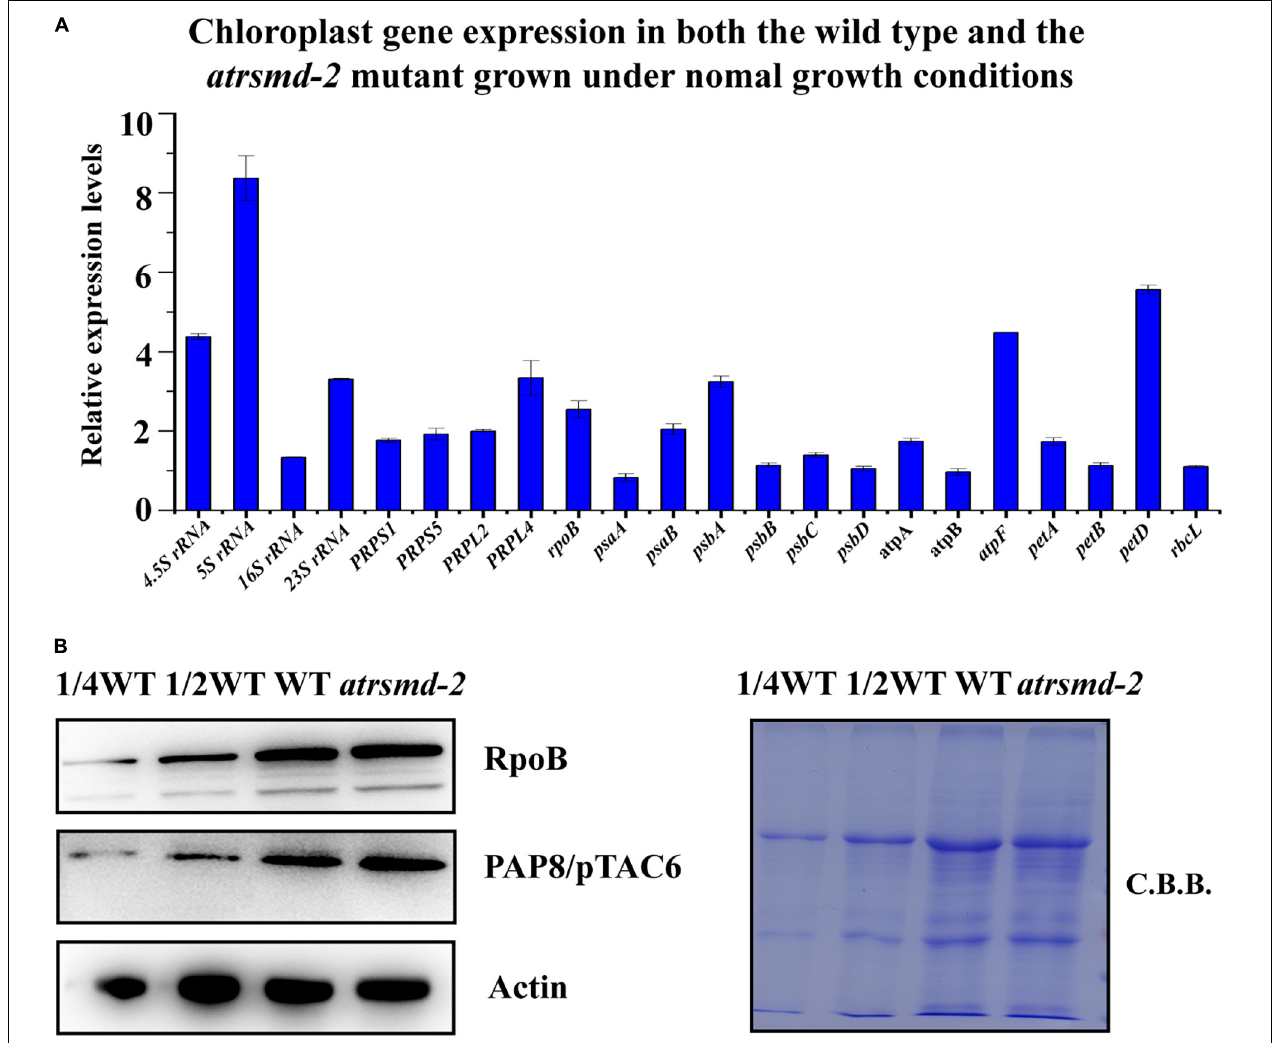
FIGURE 5 | Absence of AtRsmD affects chloroplast transcripts in the wild type and atrsmd-2 mutant. (A) Relative expression levels of chloroplast-related genes in the wild type and atrsmd-2 mutant. (B) Immunoblot analysis of the RpoB and PAP8/pTAC6 proteins of the PEP complex from the wild type (WT) and atrsmd-2 mutant was performed. Total proteins from the WT samples were loaded at three different concentrations (2.5, 5, and 10 µ g), and total proteins from the mutant samples were loaded at 10 µ